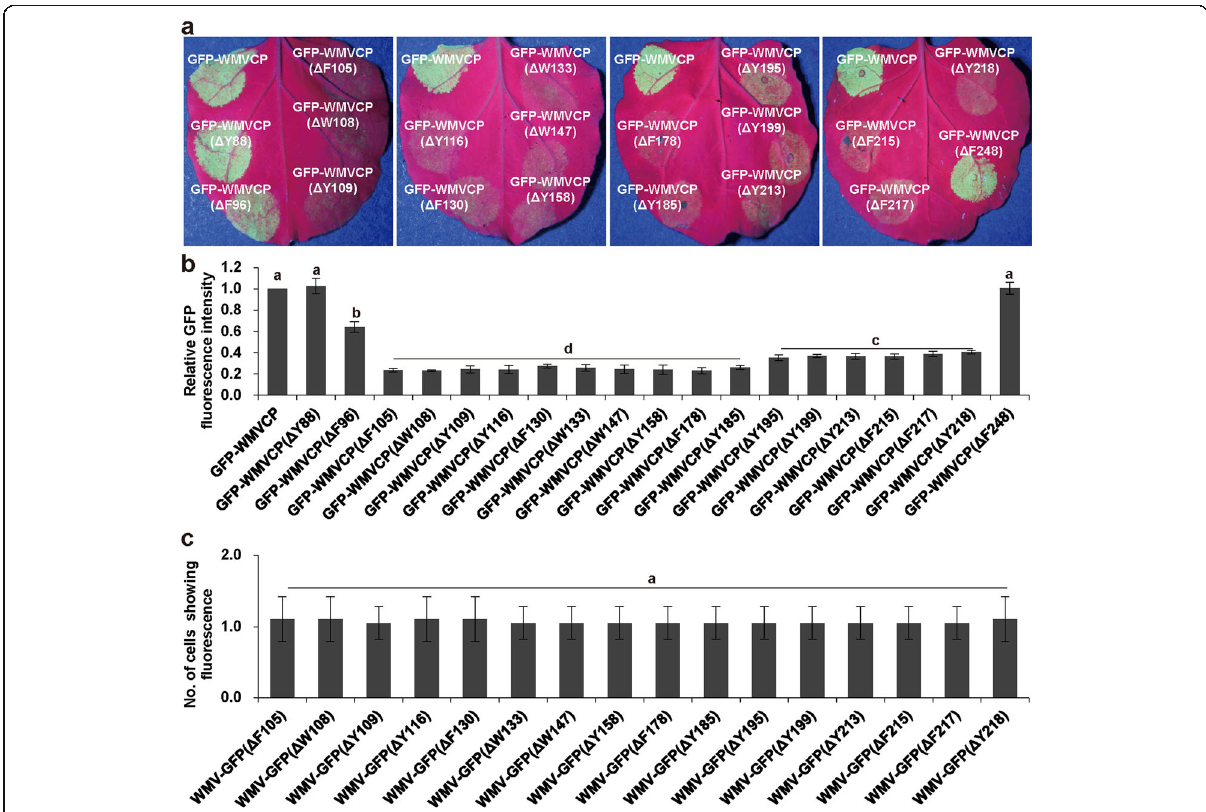
Fig. 7 Effects of π -stackings on CP accumulation and cell-to-cell movement of WMV. a GFP fluorescence and b relative GFP fluorescence intensities in the N. benthamiana leaf patches expressing GFP-WMVCP, one of its 16 mutants derived from aromatic residues (F 105 , W 108 , Y 109 , Y 116 , F 130 , W 133 , W 147